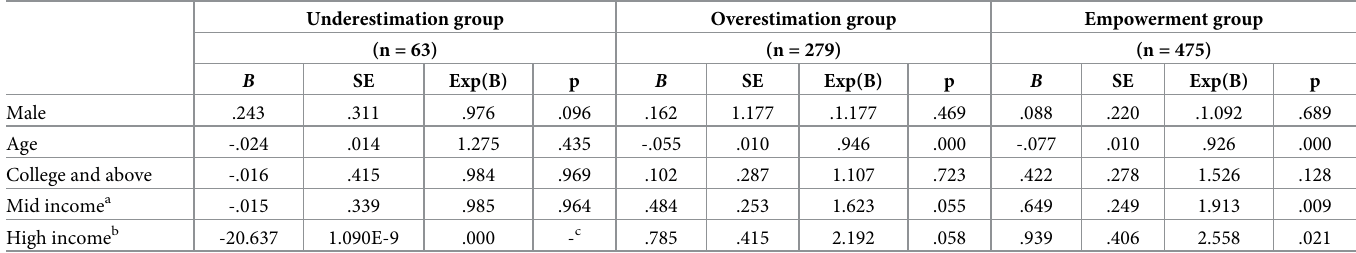
Table 3. Multinomial regression of the consumer group.